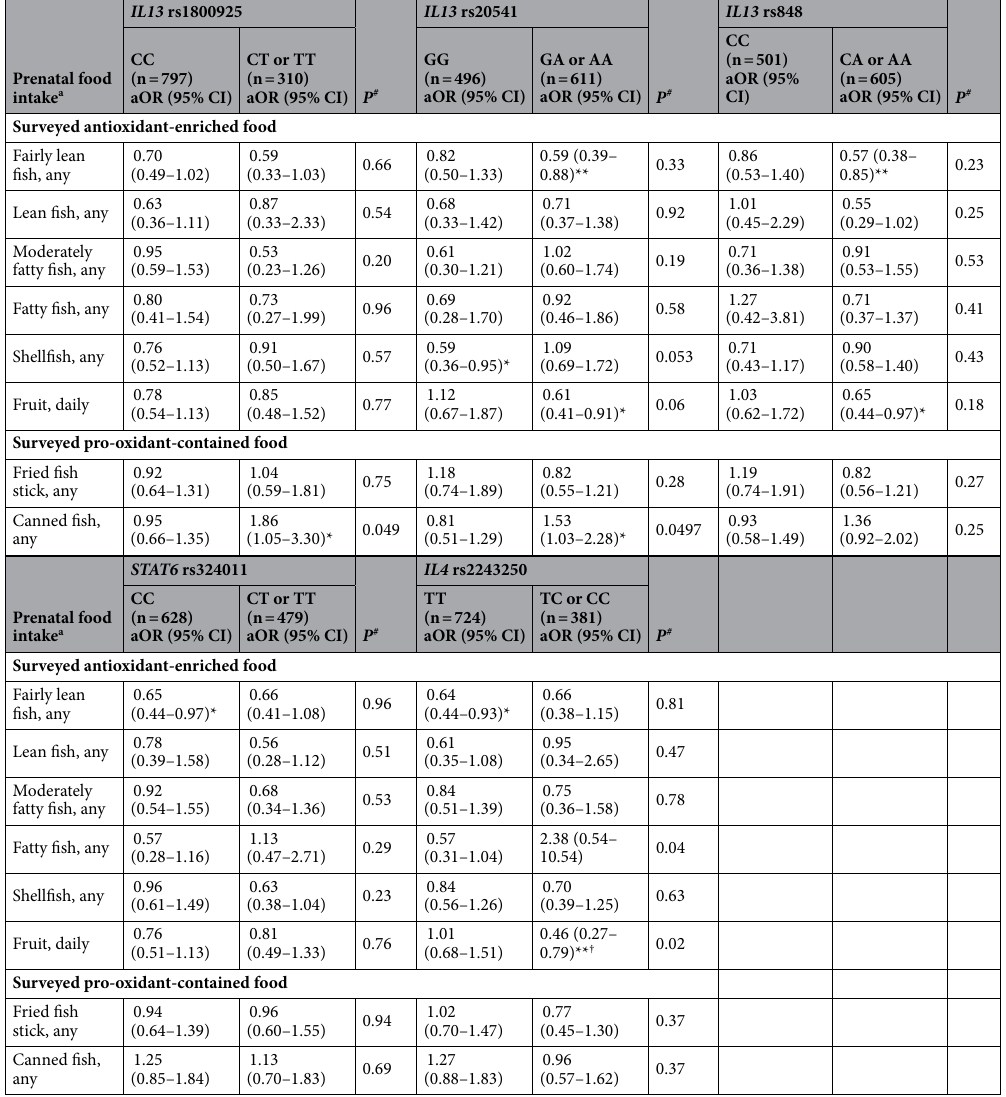
Table 3. Associations of prenatal surveyed antioxidant-enriched and pro-oxidant-contained food consumption with cord blood total IgE elevation modified by genetic polymorphisms. aOR, adjusted odds ratio; 95% CI, 95% confidence interval. # P for interaction. * P < 0.05, ** P < 0.01, † P < 0.05 after FDR correction. a Adjusted for neonatal sex, gestational age, birth body weight, maternal age, parental education, family history of atopic diseases, environmental tobacco smoke, and perception of mildewy odour.